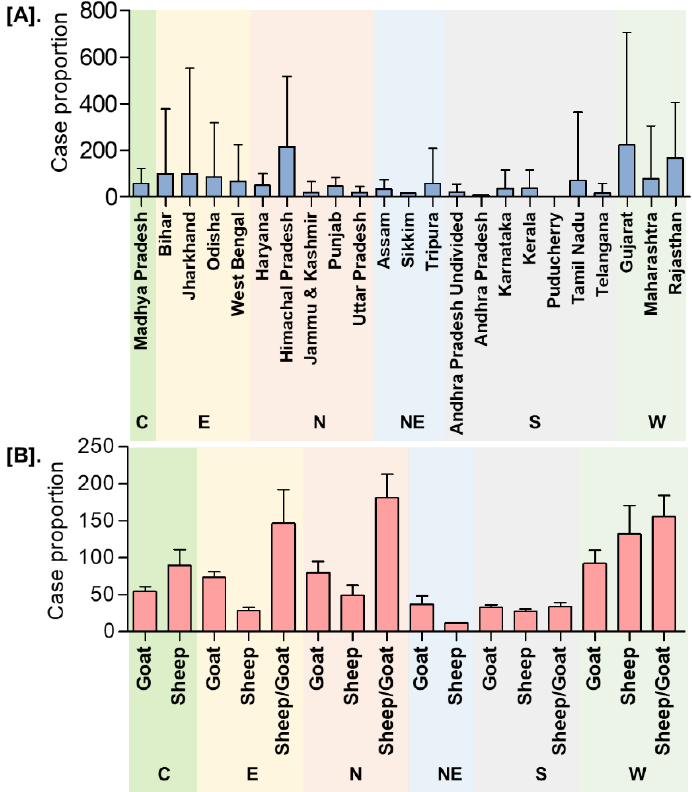
Figure 3. Dispersion analysis of the cumulative PPR reports in India (1995–2019). ( A ). State/Zone- wise ( B ). Species-wise. The mean cases per outbreak with the measure of the variation was calculated. C-Central zone; E-East zone; N- North Zone; NE-North-East Zone; S-South Zone; W-West zone. The highest mean cases per outbreak were observed in Gujarat, followed by Himachal Pradesh, Rajasthan, with the highest in sheep and goats in the West and North zone,